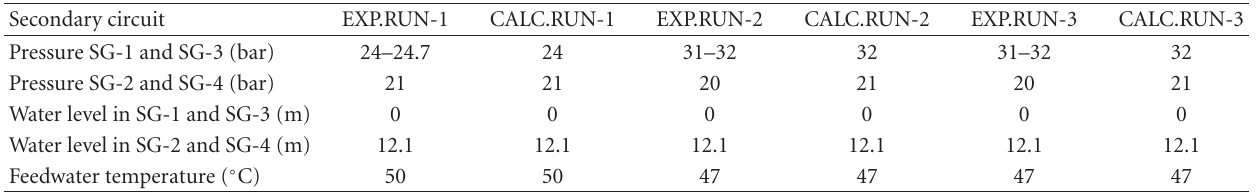
Table 7: Secondary side steady-state results versus measurements for all runs.